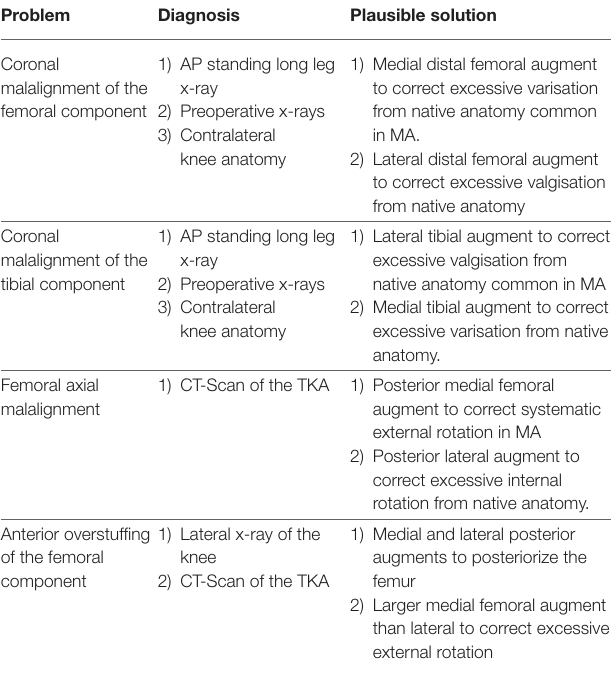
TABLE 1 | Estimated angular correction given by apposing a tibial component with a unilateral augment to a uniformly flat bone surface. Tibia size # Tibia width (mm)